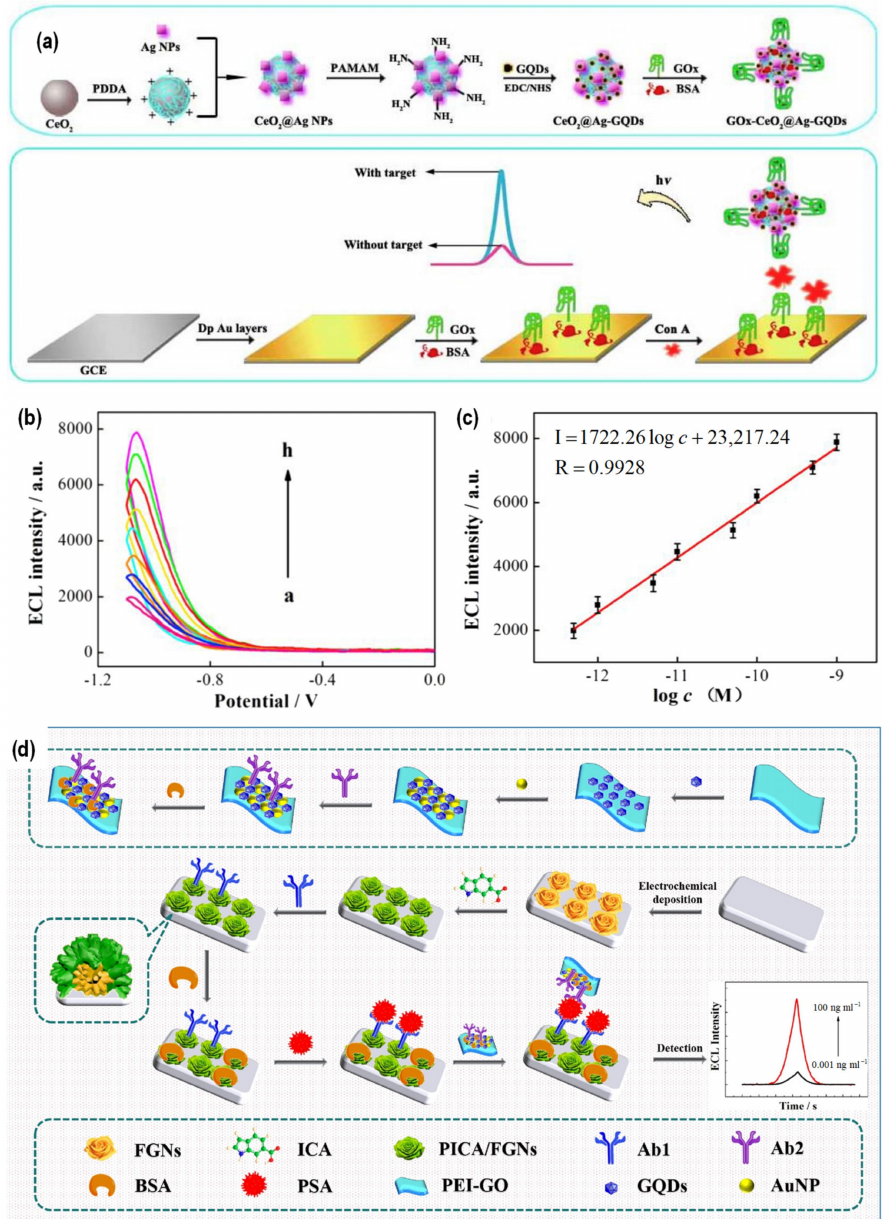
Figure 11. GQD nanocomposites as ECL-based biosensors. ( a ) Schematic illustration of the fabrication of GOx-CeO 2 @Ag-GQDs nanocomposites for ECL-based detection of Con A. ( b ) ECL spectra of GOx-CeO 2 @Ag-GQDs nanocomposites with different concentrations of Con A, including 0.5, 1.0, 5, 10, 50, 100, 500, 1000 pg/mL (from a to h). ( c ) The corresponding linear correlation between logarithmic Con A concentrations and ECL intensities of GOx-CeO 2 @Ag-GQDs nanocomposites